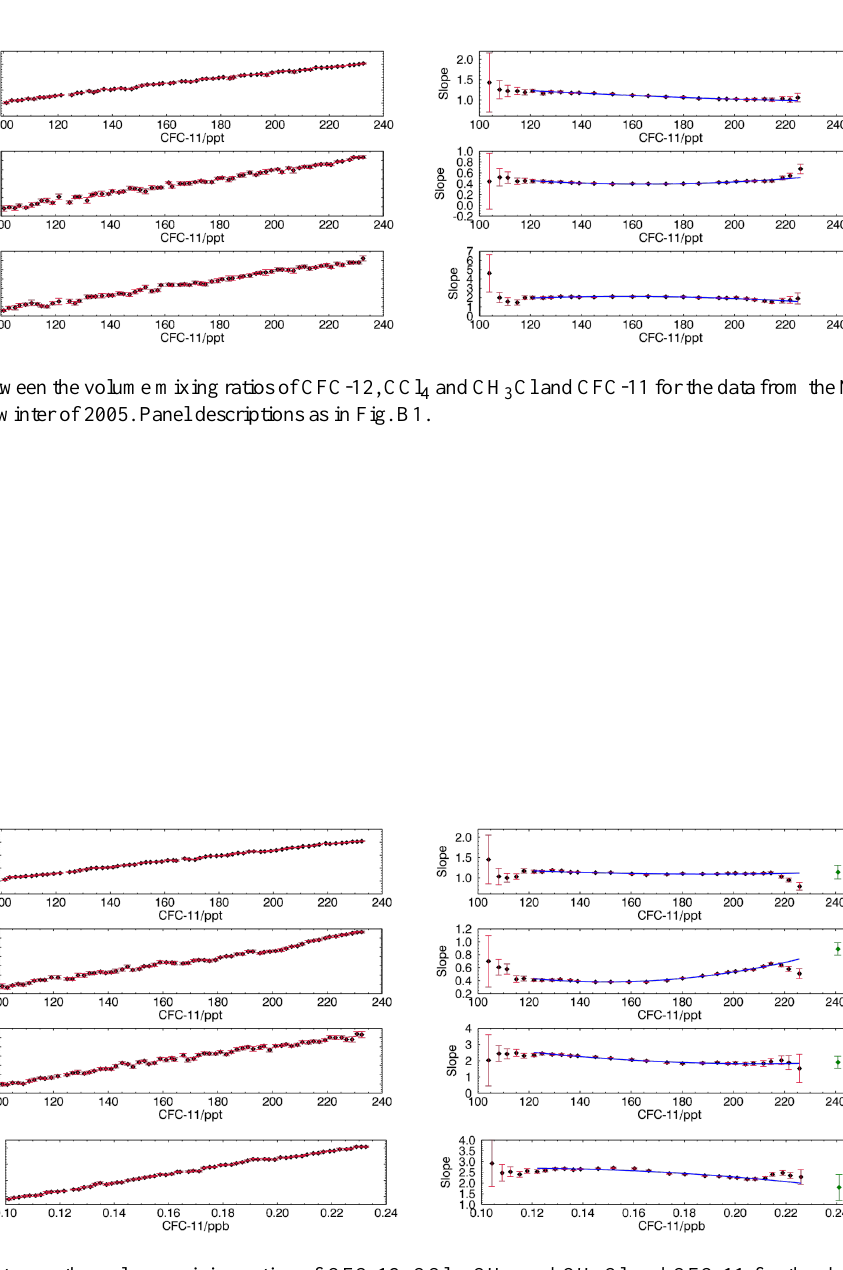
Figure B7 Correlations between the volume mixing ratios of CFC-12, CCl 4 , CH 4 and CH 3 Cl and CFC-11 for the data from the northern hemisphere during the stratospheric winter of 2006. Left panels: The mean correlation profile. Each point represents the mean of the VMR in a window of 2 ppt of CFC-11. The error on these points is the standard deviation of the data within each 2 ppt window. Right panels: The local slope of data in an 80 ppt of CFC-11 window. The error on the points is the fitting error of this fit. The blue line is a second degree polynomial fit to the local slopes. The green point is the extrapolated slope at the tropopause.